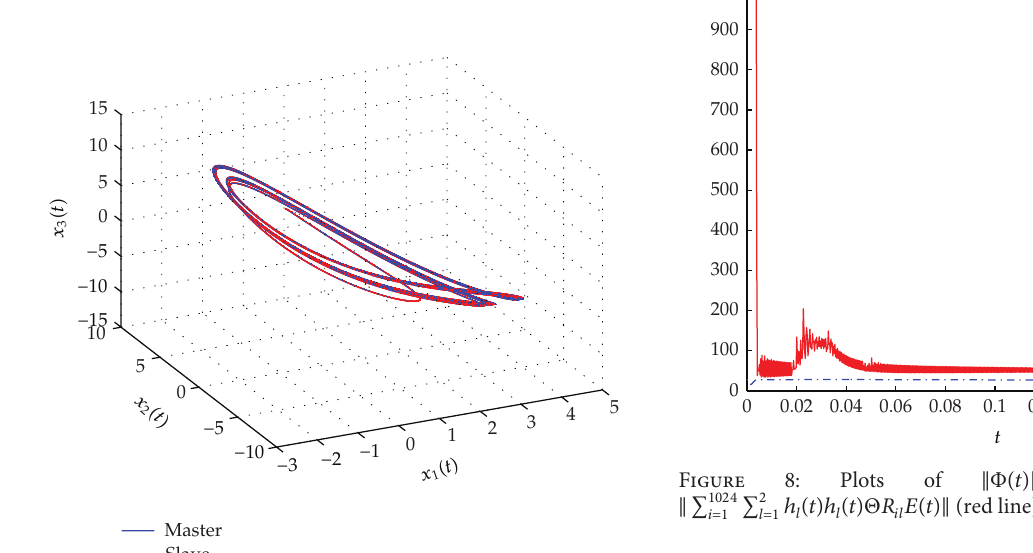
Figure 5: State responses of both master and slave systems.